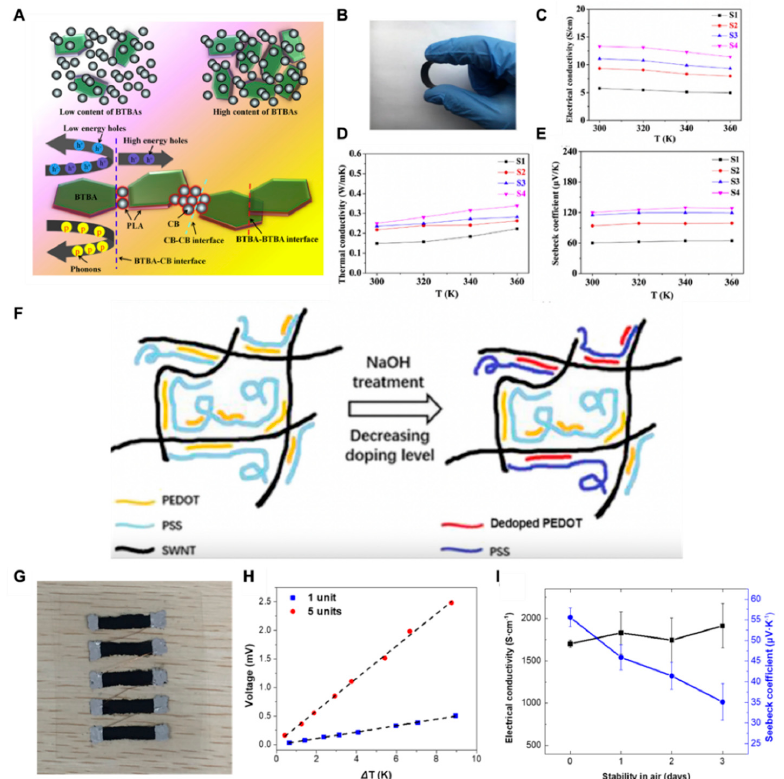
( B ) the camera image of hybrid Bi2Te3/CB film; ( C ) corresponding electrical conductivity at